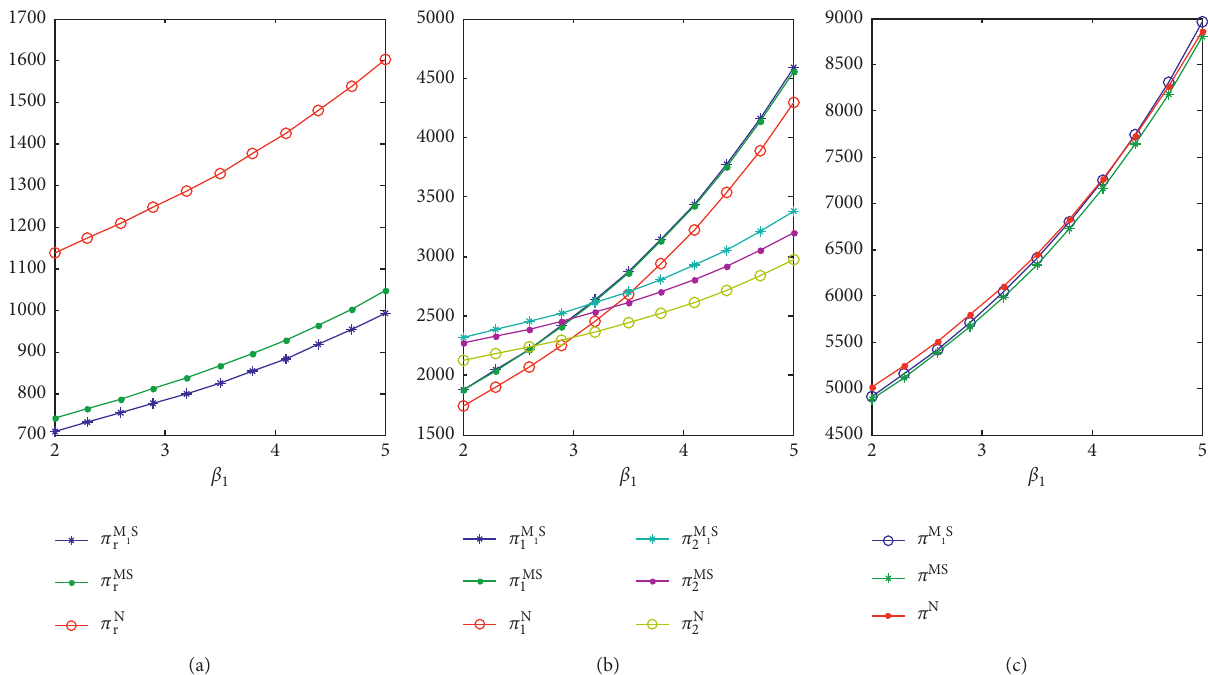
Figure 2: The effect of β on the optimal profits in three models: (a) retailer profit; (b) manufacturer profit; (c) total 1